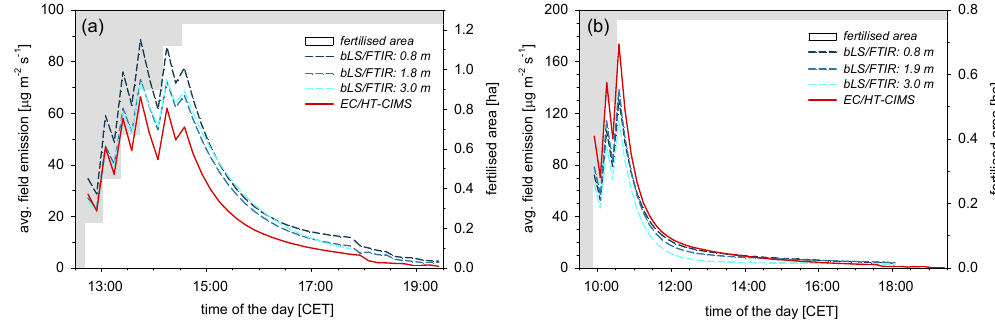
Fig. 7. Average field emissions on (a) 4 August 2009 and (b) 6 August 2009 derived from EC/HT-CIMS and